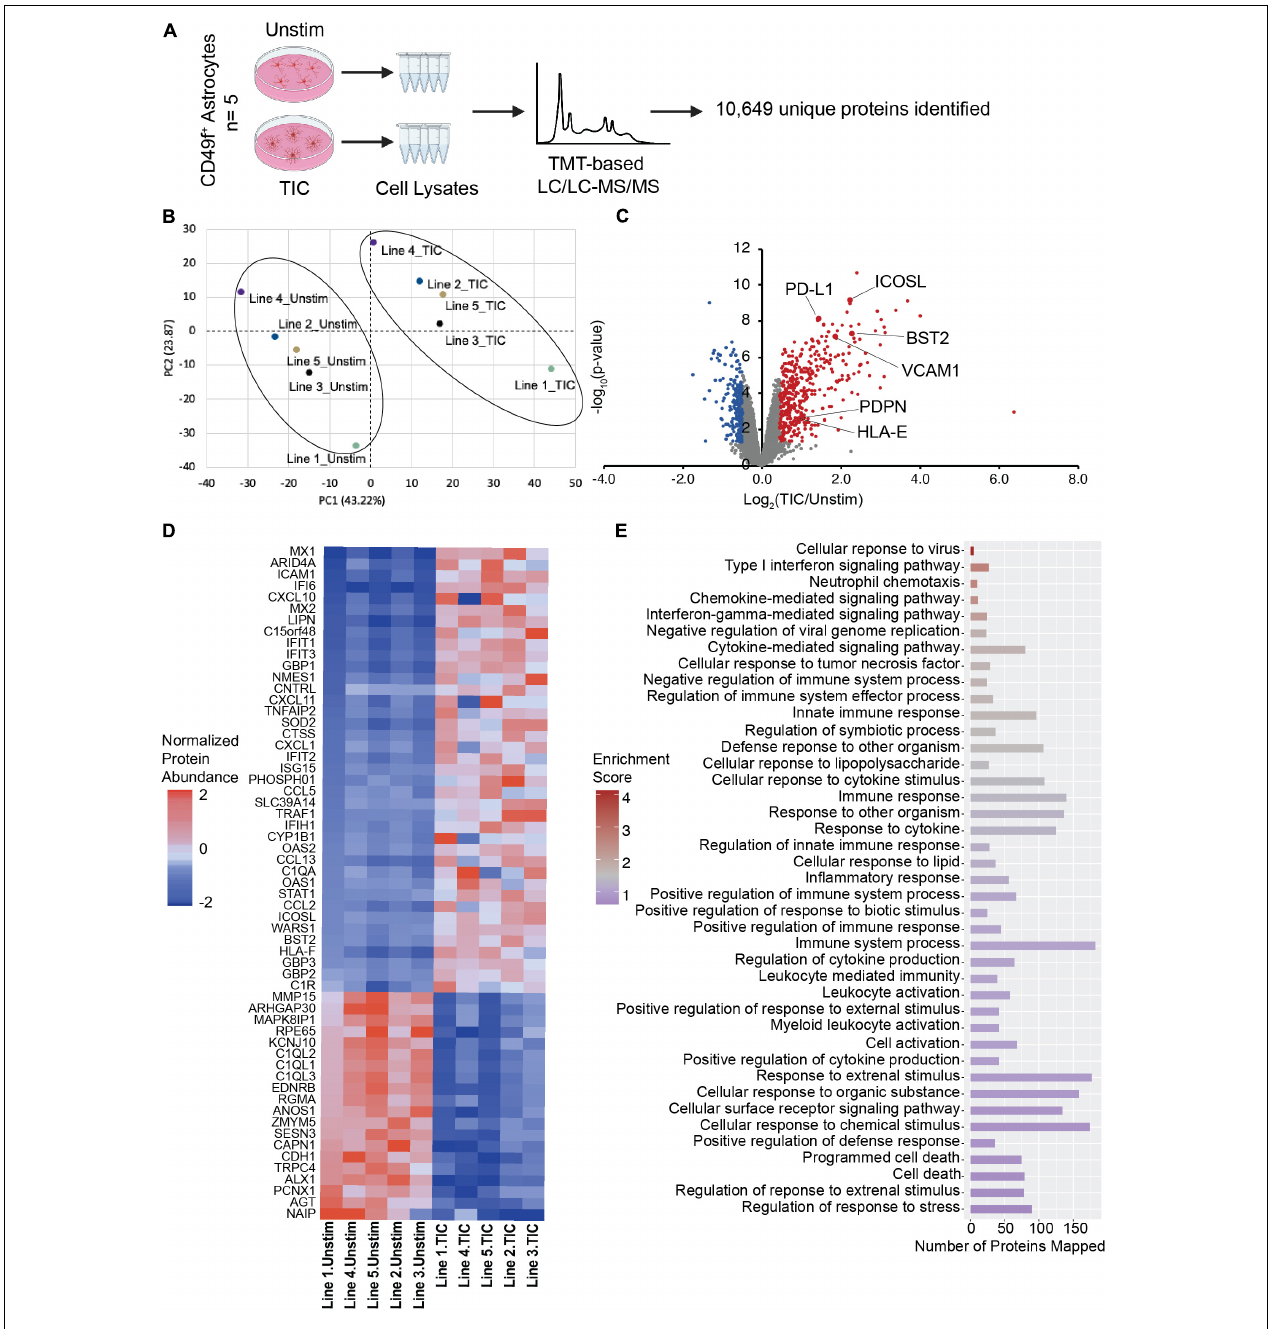
FIGURE 4 | Proteomic analysis implicates TIC-stimulated reactive astrocytes interaction with peripheral immune cells and neurotoxic biological processes. (A) Schematic of proteomic analysis workflow performed with TIC-induced reactive versus unstimulated astrocytes. (B) Principal component analysis using top 10% most variable proteins displays clustering of unstimulated and TIC-stimulated astrocytes. (C) Volcano plot of differentially expressed proteins. Proteomic analysis further validated the six markers identified through flow cytometry screen, which are highlighted. For significance threshold, P -value < 0.05 and z -scores > 2 were used. (D) Heatmap of top 10% most variable proteins in TIC-induced reactive versus unstimulated astrocytes. (E) Pathway enrichment analysis using 601 differentially expressed proteins highlights biological processes involved in immune response and inflammatory